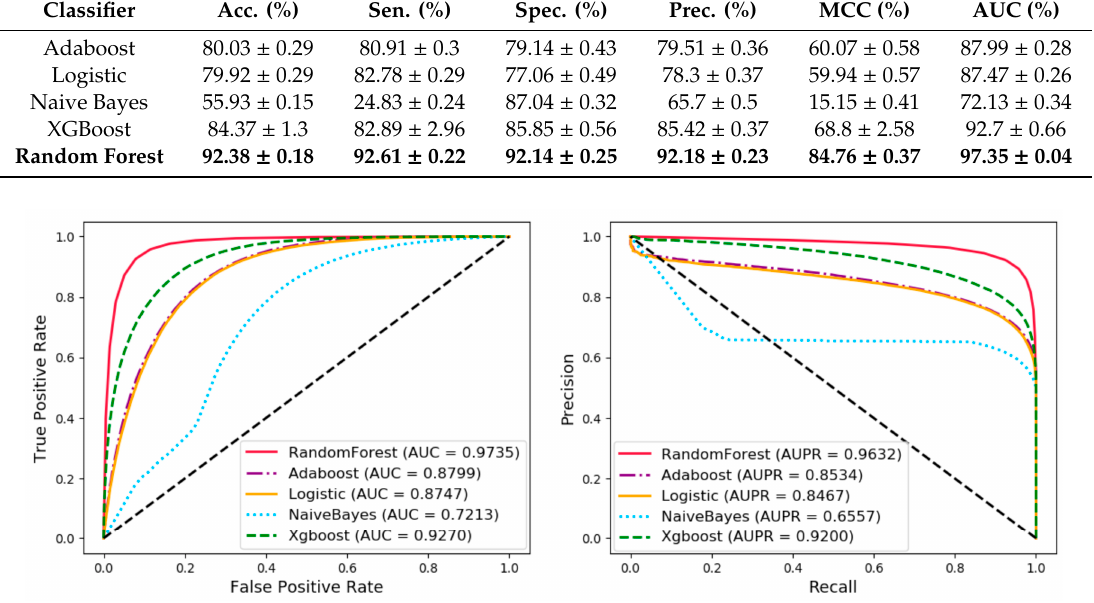
Figure 6. Comparison with random forest, Adaboost, logistic regression, naive Bayes, and XGBoost under five-fold cross validation.